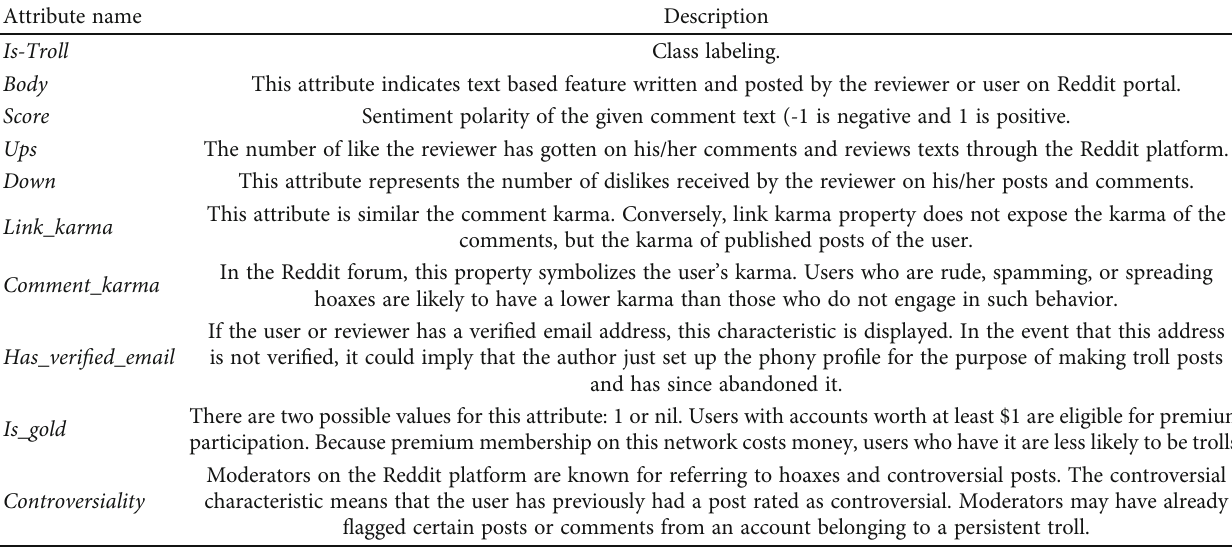
Table 1: Description of the attributes of the used dataset.